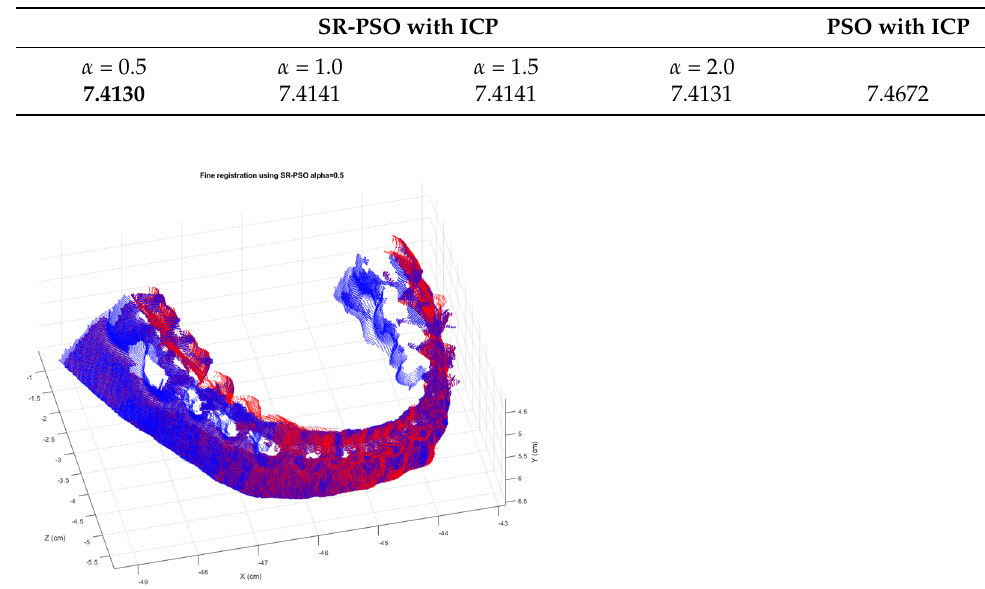
Table 10. MSE of the final registration of six consecutive views (micrometer 2 ) for the orthodontic- tooth model (the best value is in bold).